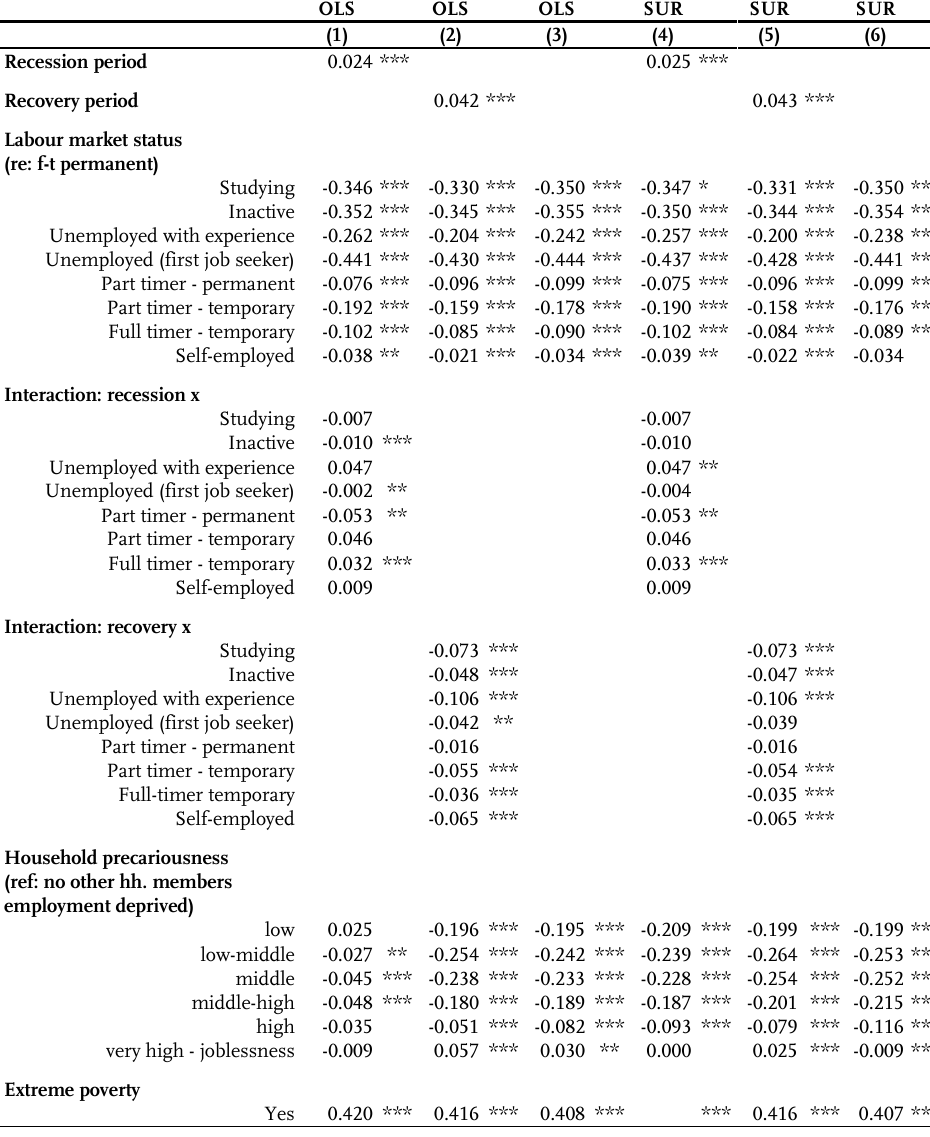
Table 3b: OLS and Seemingly Unrelated Regression results on emancipation males between 26-34 years of age (1=cohabiting).